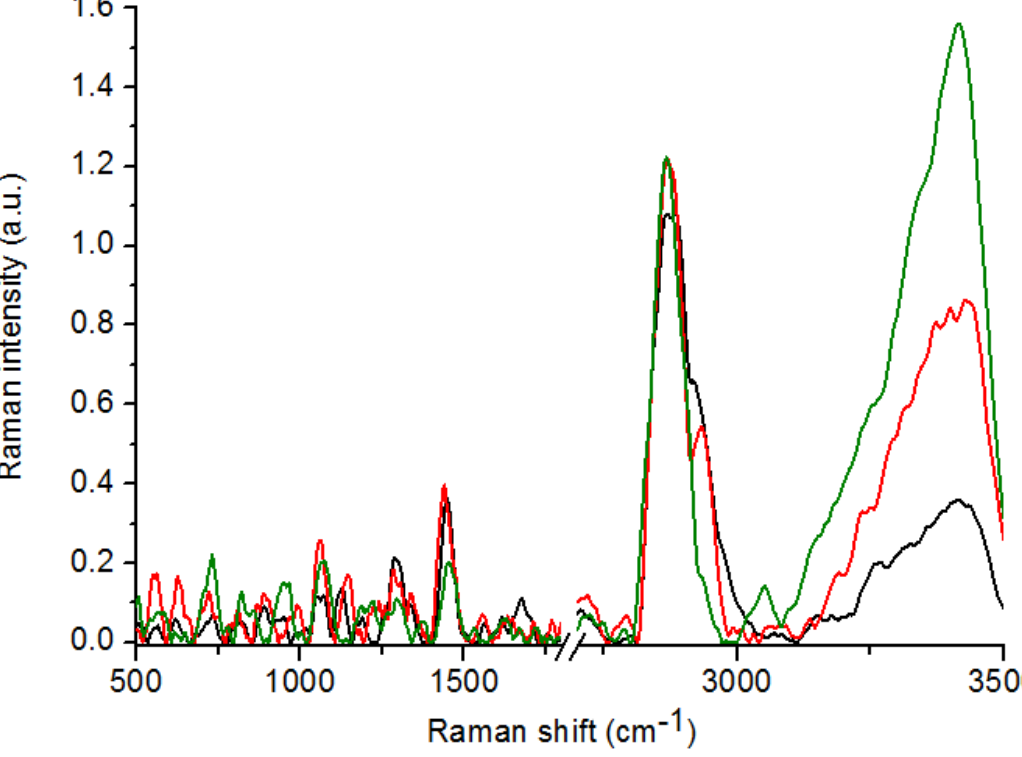
Figure 1. Raman spectra of: control ( n = 17, green spectrum); atypical hyperplasia ( n = 12, black spectrum) and cancer ( n = 16, red spectrum)